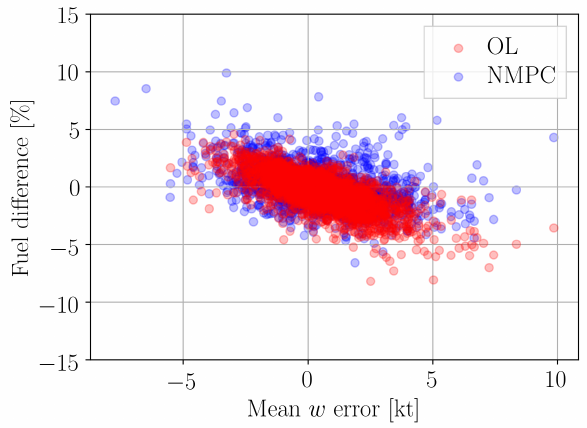
Figure 9. Fuel consumption difference with respect to initial